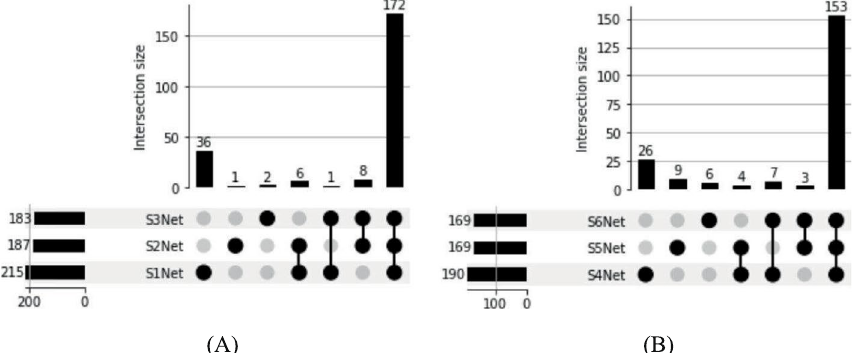
Fig. 1 Comparison of protein information among different active networks. Note: A Three active networks S1Net, S2Net and S3Net in the inactive state of EET. B Three active networks S4Net, S5Net and S6Net in the activated state of EET